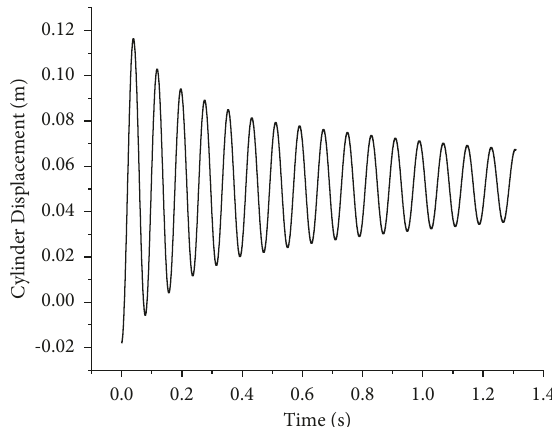
Figure 4: Free vibration of the cylinder in the stationary fluid.